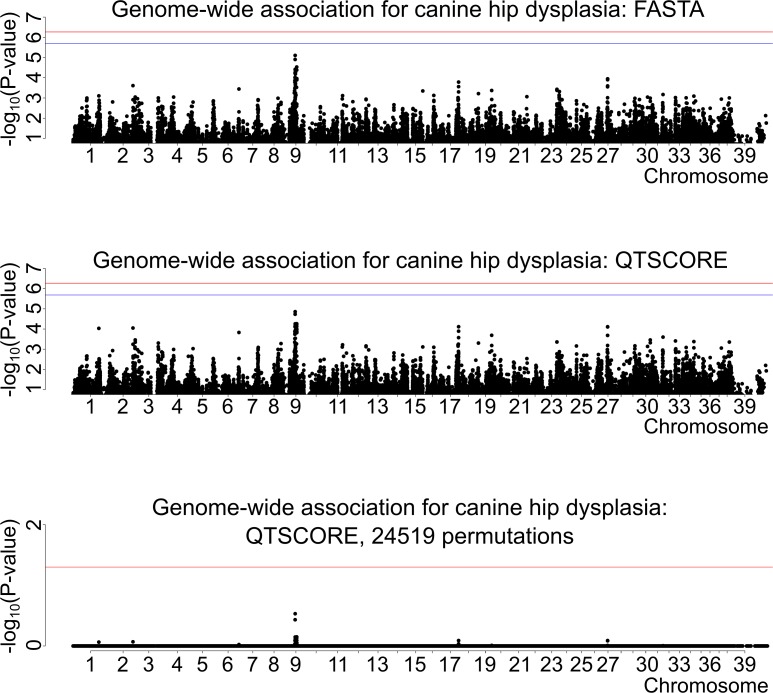
Genome-wide association for canine hip dysplasia: FASTA and QTSCORE, N(cases) = 132, N(controls) = 160.For the upper two figure segments the red horizontal lines are the thresholds for Bonferroni correction for significance. The blue horizontal line is the threshold for significance for independent tests. In the undermost segment, where the permuted P-values are shown, the single red line represents the threshold for genome-wide significance level of 0.05.